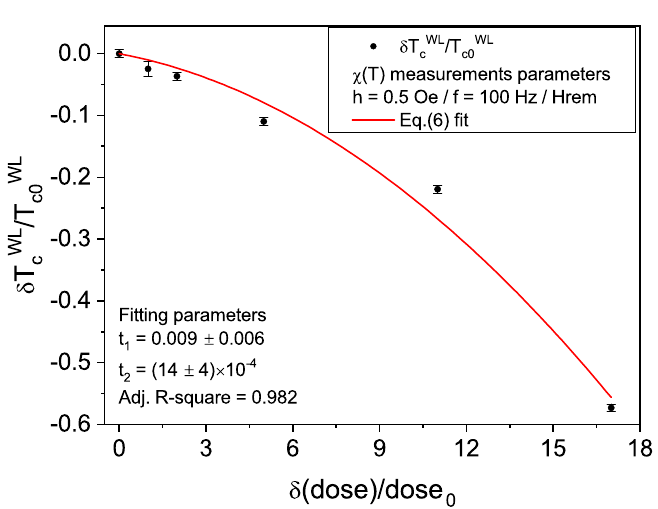
Figure 6. Relative change of the critical temperature as a function of the relative beam dose used during groove milling. Red solid curve is the fit of Equation (6) using the FIB dose as control parameter. This analysis demonstrates that the data follows the expected trend for strong-coupled